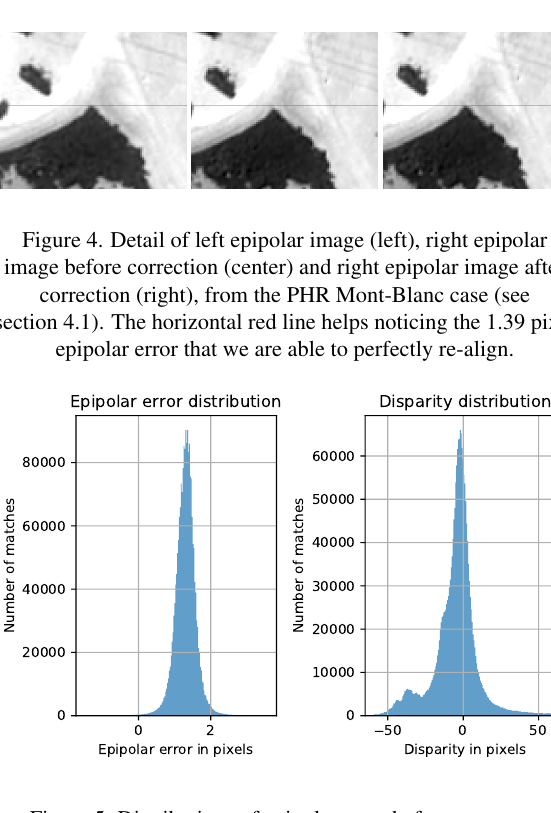
Figure 5. Distributions of epipolar error before geometry refinement (left) and disparity after geometry refinement (right) from sparse matches, computed on full epipolar images of the PHR Mont-Blanc case (see section